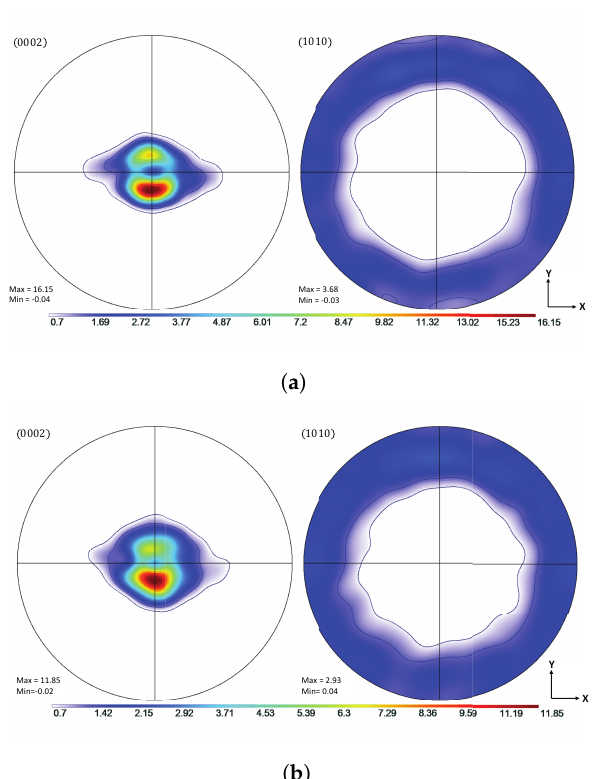
Figure 5. Comparison of simulated and experimental textures under TTC load conditions at (cid:101) = 0.09 . ( a ) Simulated { 0002 } and { 1010 } pole figures. ( b ) Experimental { 0002 } and { 1010 } pole